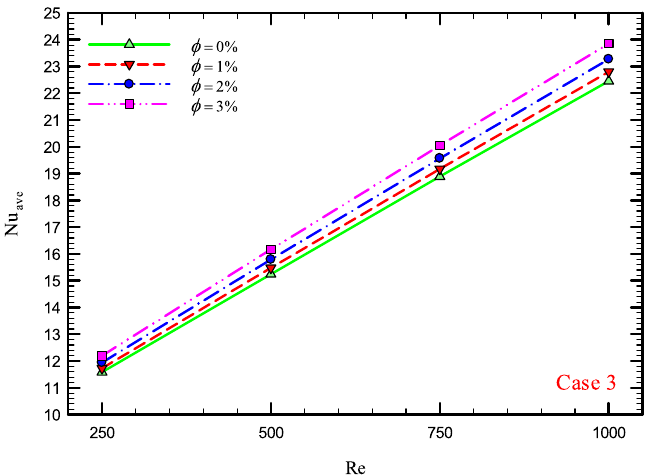
Figure 11. Nu ave versus Re for Case 3.